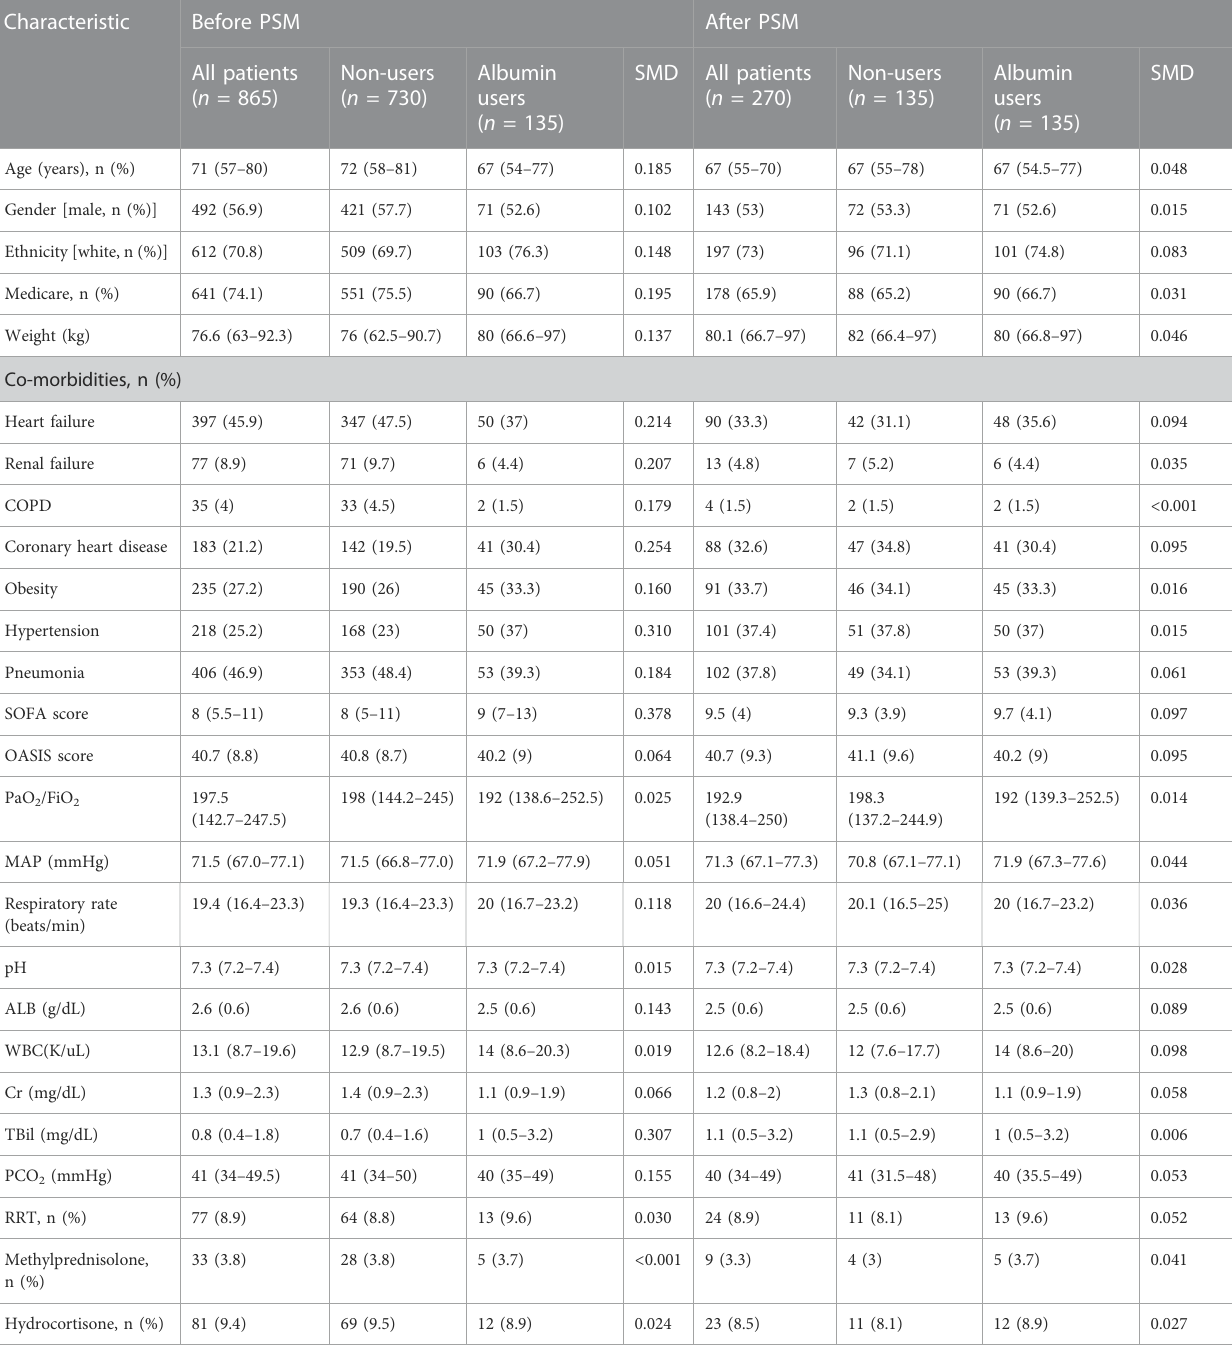
TABLE 1 Baseline characteristics of unmatched and matched study